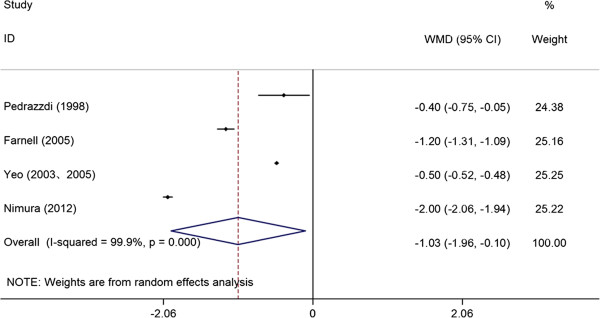
Forest plot for the operative time between the pancreatoduodenectomy with extended lymphadenectomy (PD/ELND) group and the standard pancreatoduodenectomy (PD) group. The size of the black box corresponding to each study is proportional to the sample size, and the horizontal line shows the corresponding 95% CI of the relative risk (RR) displayed on the right.